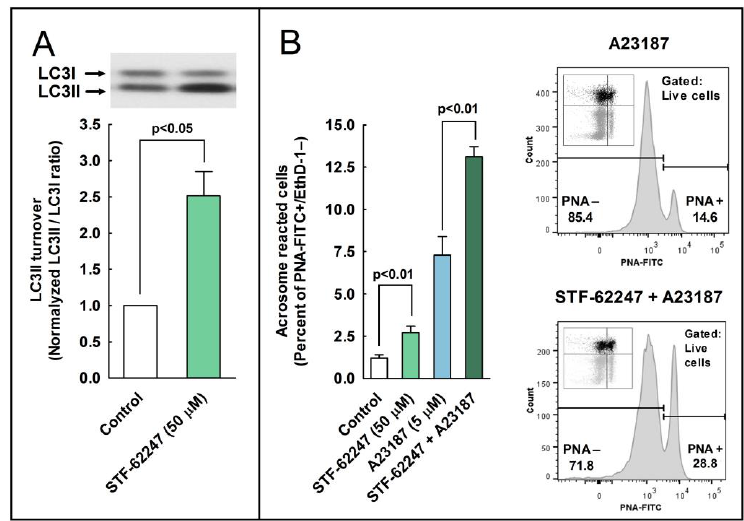
Figure 6. The effect of autophagy inducers on the processing of LC3II and the development of the acrosome reaction in stallion sperm cells. ( A ) Stallion spermatozoa were incubated for 3 h in BWW at 37 °C in the presence or absence (vehicle) of STF-62247 (50 µM). After incubation, LC3II pro- cessing from LC3I was assessed by western blotting and was expressed as normalized LC3II/LC3I ratio (control samples always equal 1). Values represent the mean ± SEM of 4 independent experi- ments. A two- tailed Student’s t -test for unpaired samples was applied to compare the means of each group with the significance level set at 0.05, as is indicated in the figure. In the top of the panel, there is an immunoblotting representative of three others. ( B ) Stallion spermatozoa were incubated for 150 min in BWW at 37 °C in the presence or absence (vehicle; DMSO) of STF-62247 (50 µM) and then were challenged with 5 µM A23187 or the vehicle (Control) for 30 additional min (the final incuba- tion time in capacitating conditions was 180 min). After incubation, spermatozoa were washed with PBS and labeled with probes to characterize, by flow cytometry, the DNA content (Hoechst 33342), the cellular viability (EthD-1), and the acrosome reaction (PNA-FITC). To select the sperm popula- tion, cytometer events were selected by DNA content (Hoechst 33342+ events) and then were clas- sified in four quadrants corresponding to the detection or not of each of the remaining fluorophores, resulting in dead unreacted cells (EthD-1+ and PNA- FITC‒; Q1), dead reacted cells (EthD -1+ and PNA-FITC+; Q2), live reacted cells (EthD- 1‒ and PNA -FITC+; Q3), and live unreacted cells (EthD- 1‒ and PNA - FITC‒; Q4). Results in the graph represent the mean ± SEM of 4 independent exper i- ments expressed as the percentage of acrosome-reacted live sperm cells (Q3 quadrant). A two-tailed Student’s t -test for unpaired samples was applied to compare the mean of each treatment with their respective controls. The significance level was set at 0.01, as is indicated in the figure. In the right part of the panel, there is further analysis of the acrosome-reacted cells by gating out dead cells (EthD-1+). Therefore, only live cells (EthD- 1‒) were considered for this analysis. Representative his- tograms obtained from 5 µM A23187-treated cells in the presence (top) or absence (bottom) of 50 µM STF-62247 are shown. In these histograms, there are density plots of the same cytometric data displayed in quadrants, which were included as inserts. Only the gray areas from these inserts (Q3 and Q4, live cells) were used in their respective histograms, whereas the black areas were gated out for the analysis (Q1 and Q2, dead cells).